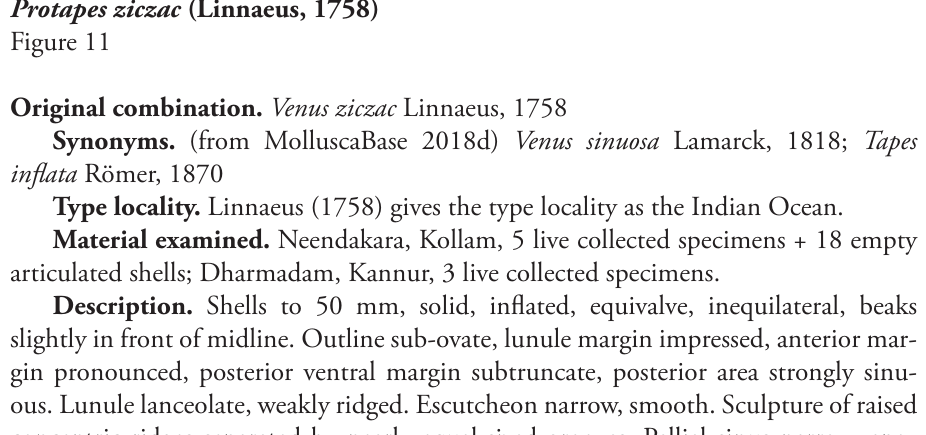
Figure10. Protapes gallus Topotype A right valve dorsal B right valve ventral C dorsal margin D left valve dorsal E left valve ventral (DABFUK), Dharmadam, Kerala, South west coast of